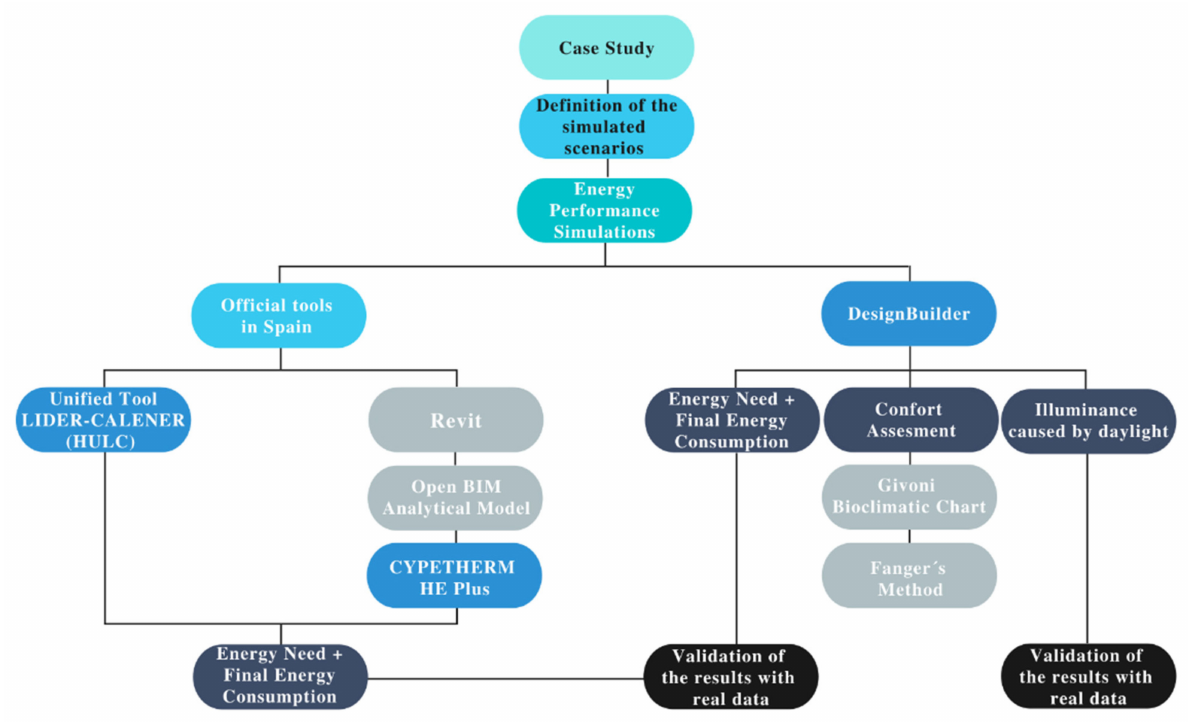
Figure 1. Flow chart: